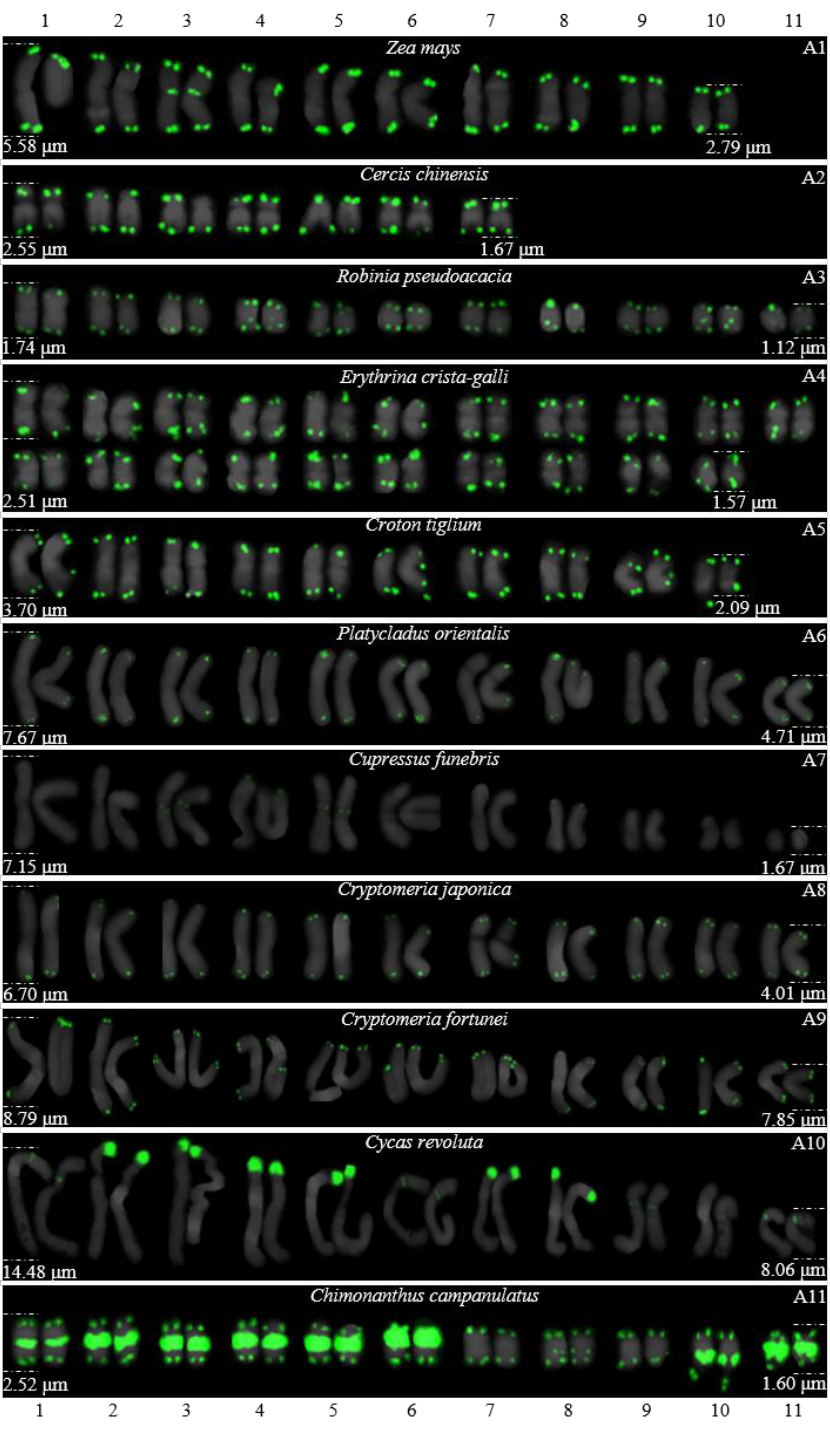
Figure 4. FISH karyograms of Z. mays and the ten woody plants from Figure 1. Oligo-probe (AG 3 T 3 ) 3 is exhibited by green signals. The upper/lower numbers (1–11) represent the chromosome pairs. The first/last chromosome of each plant were used to calculate the chromosome length: ( A1 ) Z. mays ,